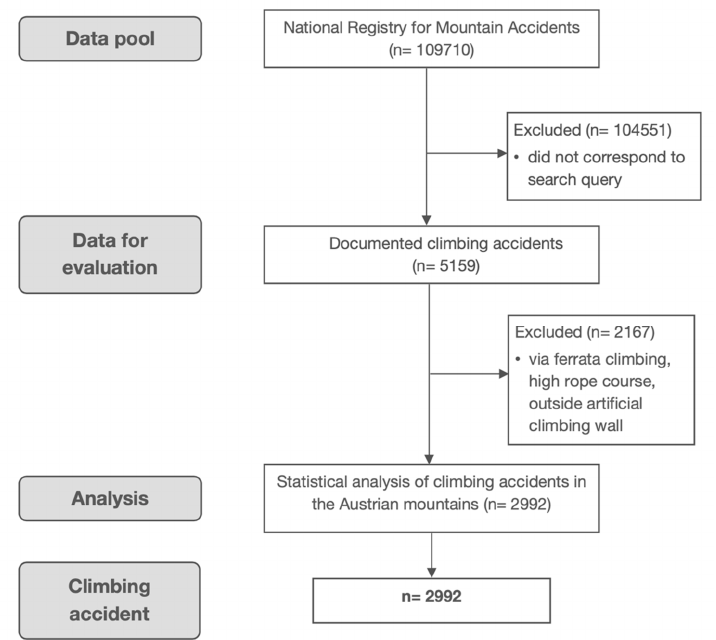
Figure 1. Consolidated Standards of Reporting Trials (CONSORT) flow chart.